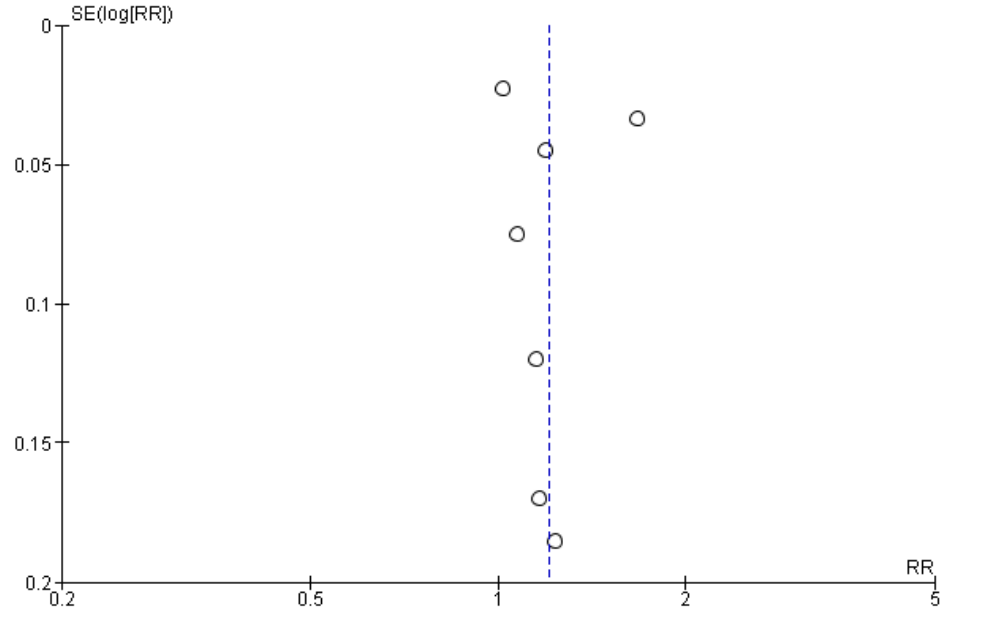
Figure 9. Funnel scatter plot assessing publication bias for seven eligible clinical studies. Potential evidence of publication bias. A graphical representation of the effect estimates from seven studies against measure of each study’s size/precision.